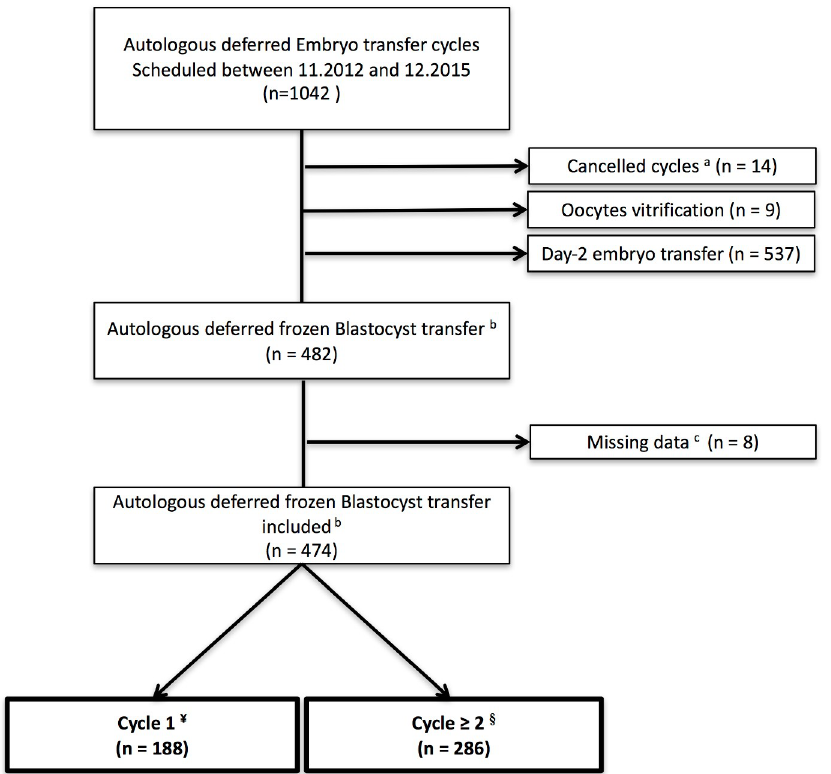
Fig 1. Patient inclusion flowchart. a Cancelled cycles: poor response; personal or medical (e.g. non-gynecological) reasons. b Only the first embryos transferred immediately after the COS were retained for the study. c Missing data: quality of embryo; pregnancy outcomes. ¥ Cycle 1: Deferred frozen blastocyst transfer performed within the first menstrual cycle. § Cycle � 2: Deferred frozen blastocyst transfer performed following one or more menstrual cycles.